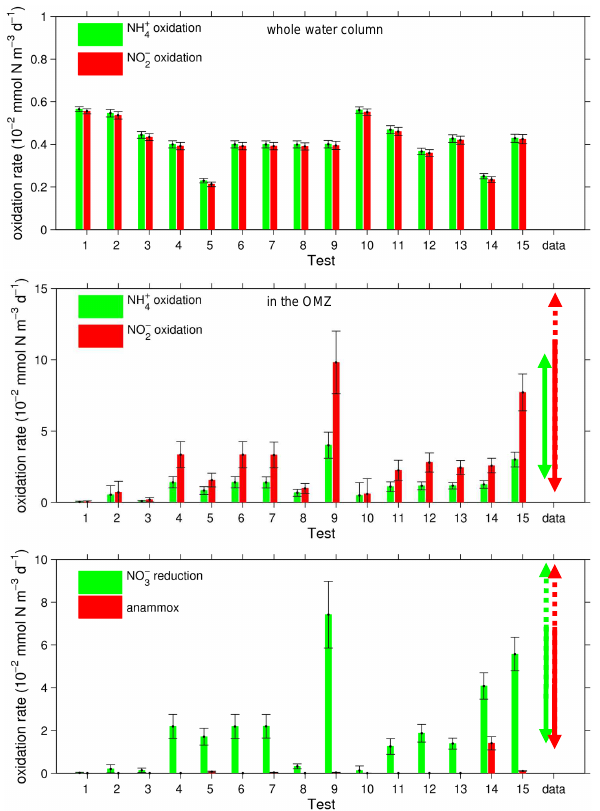
Fig. 11. NH + and NO − oxidation rates (10 − 2 mmolNm − 3 d − 1 ) 4 2 in the whole water column (top) and in the OMZ (middle). Bot- tom: NO − reduction and anammox rates (10 − 2 mmolNm − 3 d − 1 ) . 3 Rectangles represent 8yr mean values for the different tests per- formed for the sensitivity analyses, averaged between 22–24 ◦ S and 10–15 ◦ E, and black bars represent the standard deviation of the 8 annual mean values (Y12–Y19) for these different quantities. The range of in situ data is added to the right of the histogram (values are reported in Table